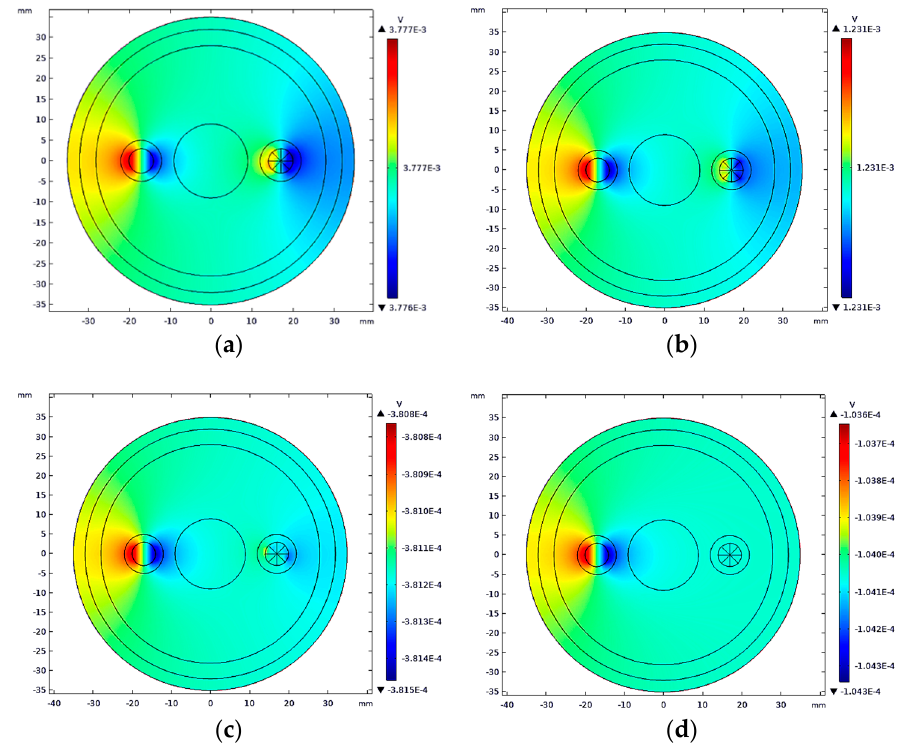
Figure 11. The induction potential profiles of arteries with different rates of stenosis: ( a ) Rate of stenosis: 25%; ( b ) rate of stenosis: 50%; ( c ) rate of stenosis: 75%; and ( d ) rate of stenosis:100%.